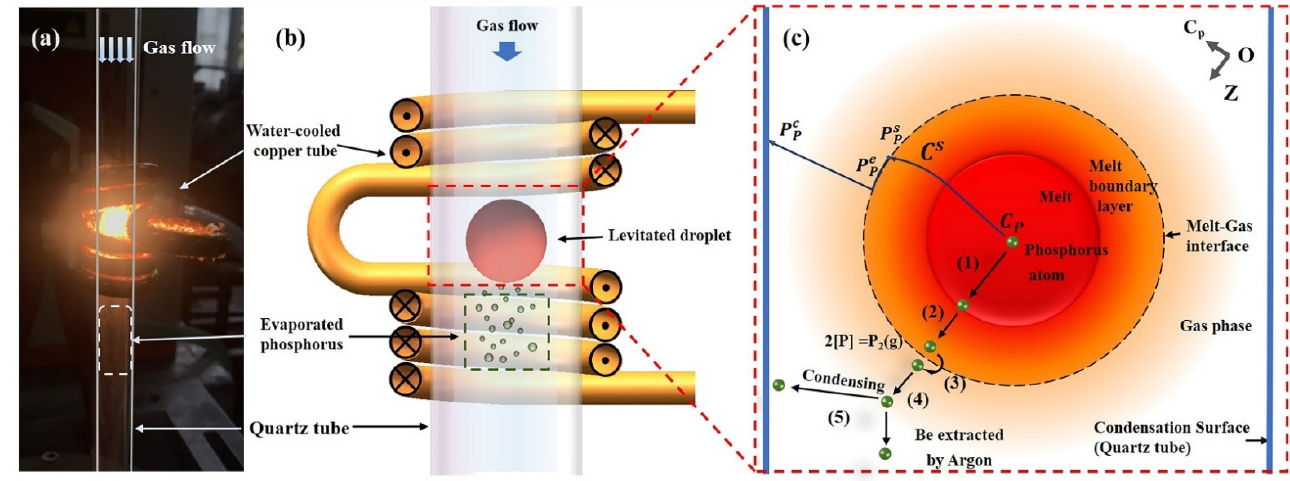
Figure 1. ( a ) Photograph of the levitated droplet ( b ) schematic diagram of the levitation cell and ( c ) schematic representation of the phosphorus removal process.